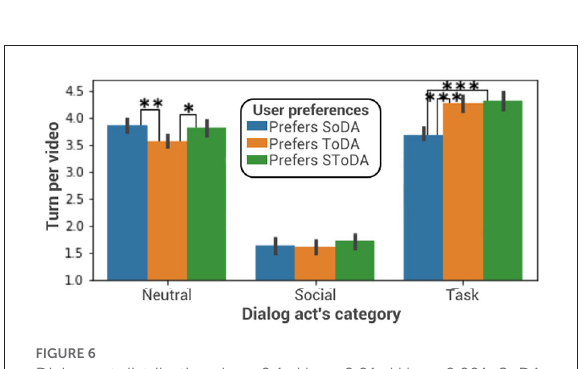
FIGURE6 Dialog act distribution. * p ≤ 0.1; ** p ≤ 0.01; *** p ≤ 0.001. SoDA, socially-oriented dialog act; ToDA, task-oriented dialog act; SToDA, socially- and task-oriented dialog